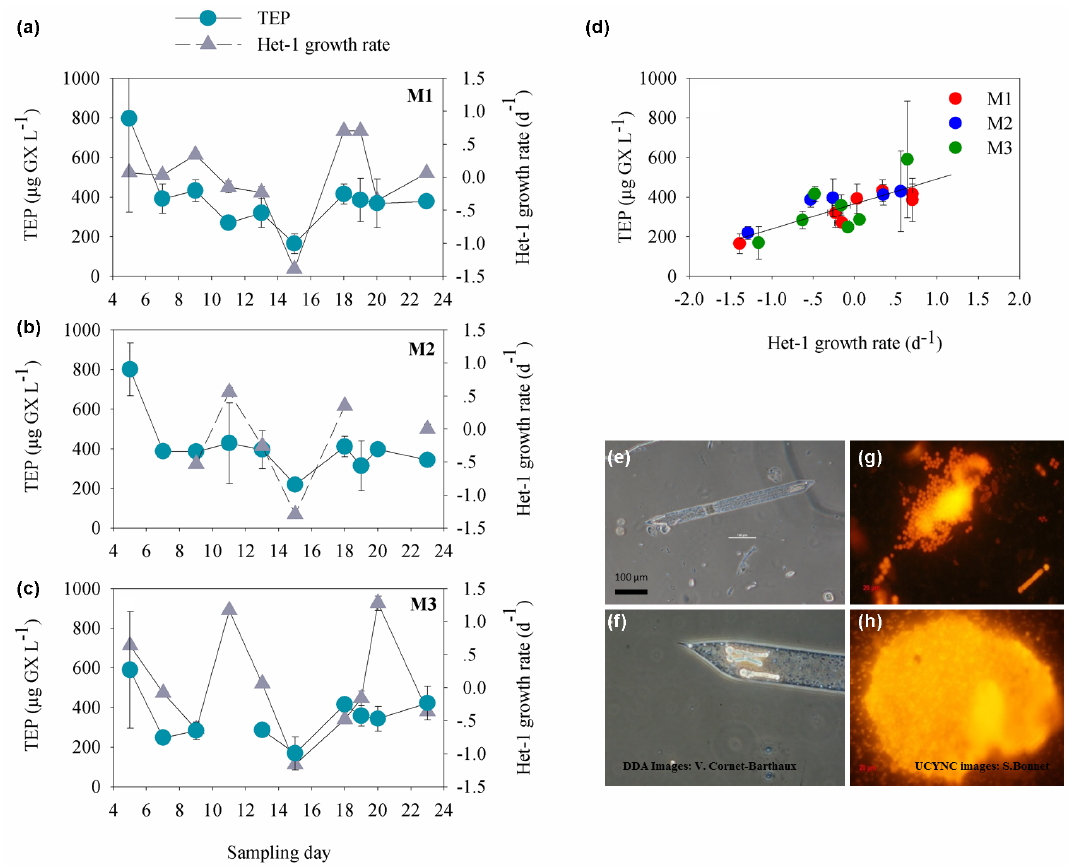
Figure 6. Temporal changes in TEP concentrations and Het-1 net growth rates (d − 1 ), (gray triangles) for (a) Mesocosm 1 (M1), (b) Meso- cosm 2 (M2), and (c) Mesocosm 3 (M3). TEP concentrations were averaged from the three depths sampled per mesocosm (green circles). Het-1 net growth rates were calculated based on changes of nifH copies L − 1 (Turk-Kubo et al., 2015) measured every other day. (d) Re- lationship between TEP concentrations (µgGXL − 1 ) and Het-1 growth rate (d − 1 ) for all three mesocosms. Significant correlations were observed (Pearson) from all mesocosms together. R 2 = 0 . 60, p = 0 . 0001, n = 19. Error bars represent ± 1 standard deviation. (e, f) Epi- fluorescent microscopical images of the diatom–diazotroph association Richelia–Rhizosolenia identified by Het-1 abundance. Images by V. Cornet-Barthaux. (g, h) The diazotroph UCYN-C which bloomed and formed large aggregates (comprised also of TEP) that enhanced vertical flux and export production during P2. Images by S.